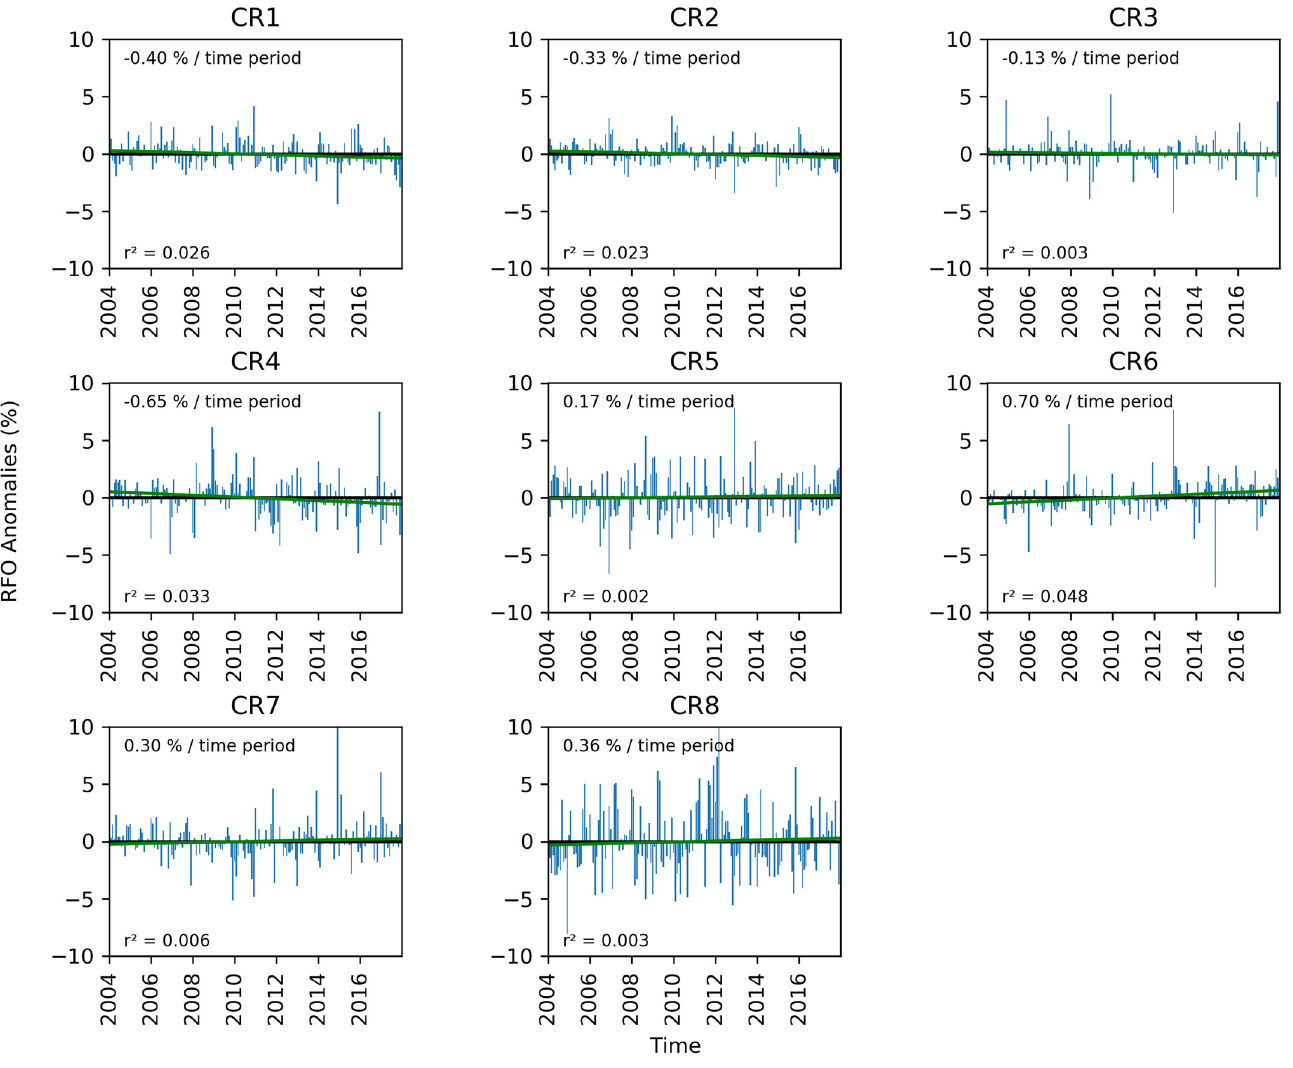
Figure 6. Inter-annual variability of the absolute monthly mean anomalies of the relative frequency of occurrence (RFO) of the 8 CRAAS cloud regimes (CRs) over Europe for the 2004–2017 period. The green line in each panel represents the linear regression fit for each time series.